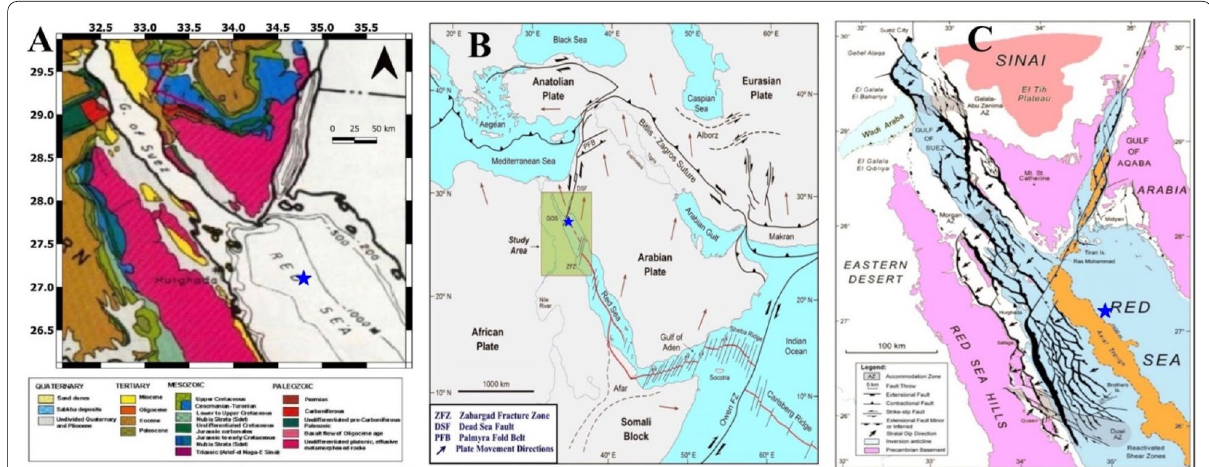
Fig. 1 A Geology map for the northern Red Sea region (from EGS, 1994). B Plate tectonic setting of the Red Sea and its surroundings modified after Khalil and MacClay (2002) and Bosworth et al (2005). C Fault pattern system for the northern Red Sea region modified after (Bosworth and McClay 2001; Cochran 2005; Khalil and MacClay 2009; Bosworth et al. 2017). The 16 Jun, 2020 earthquake location shown as blue star at each